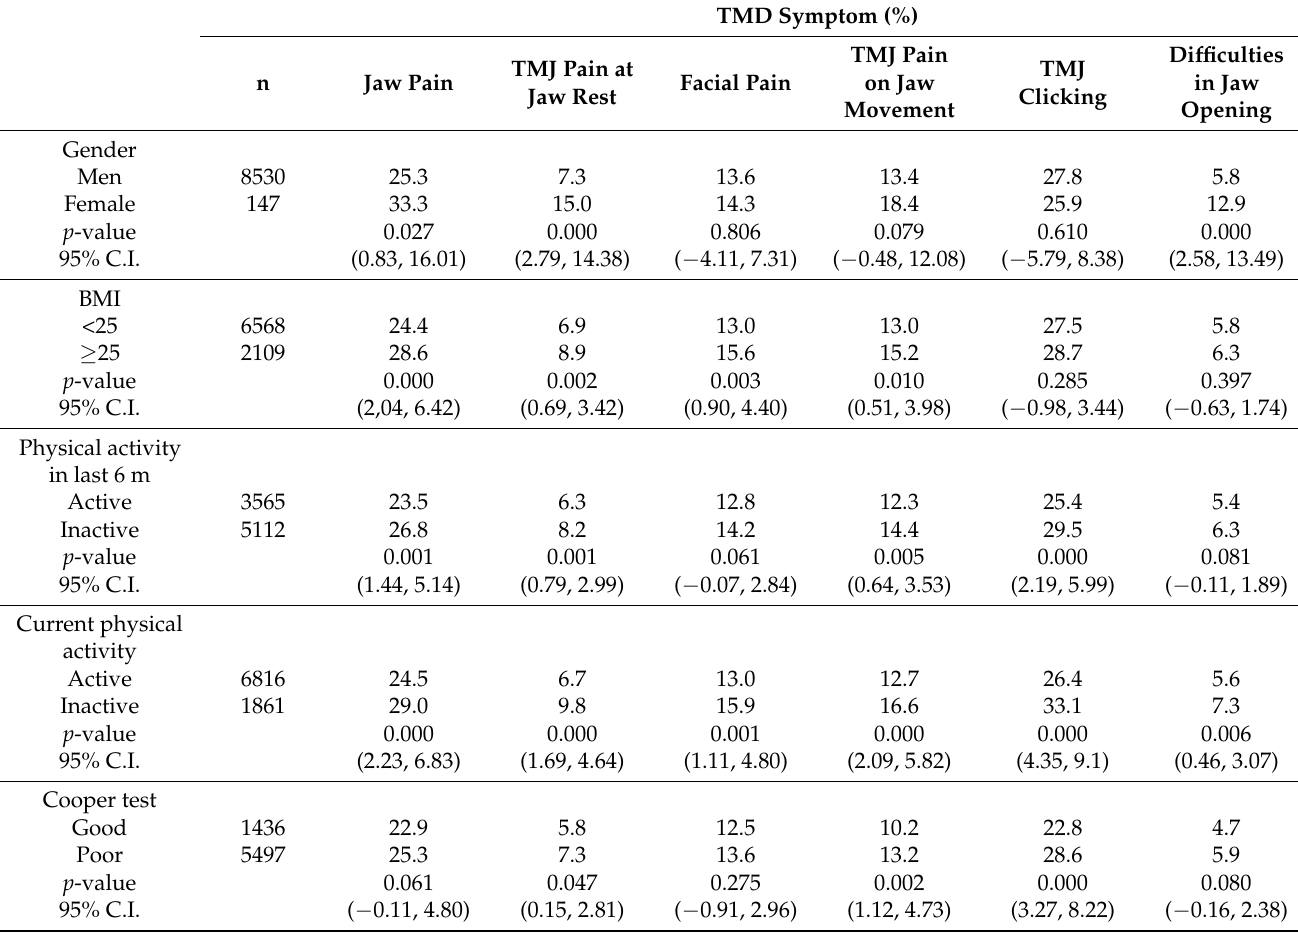
Table 1. Prevalence of TMD symptoms by gender, BMI, self-reported physical activity and physical fitness among Finnish